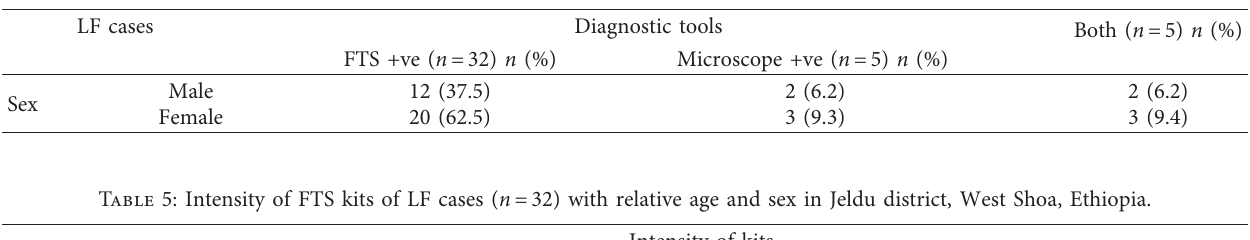
Figure 2: Distribution of LF and podoconiosis within the study villages ( n � 105), Jeldu district, West Shoa, Ethiopia. Table 4: LF cases and the diagnostic tools in Jeldu district, West Shoa,